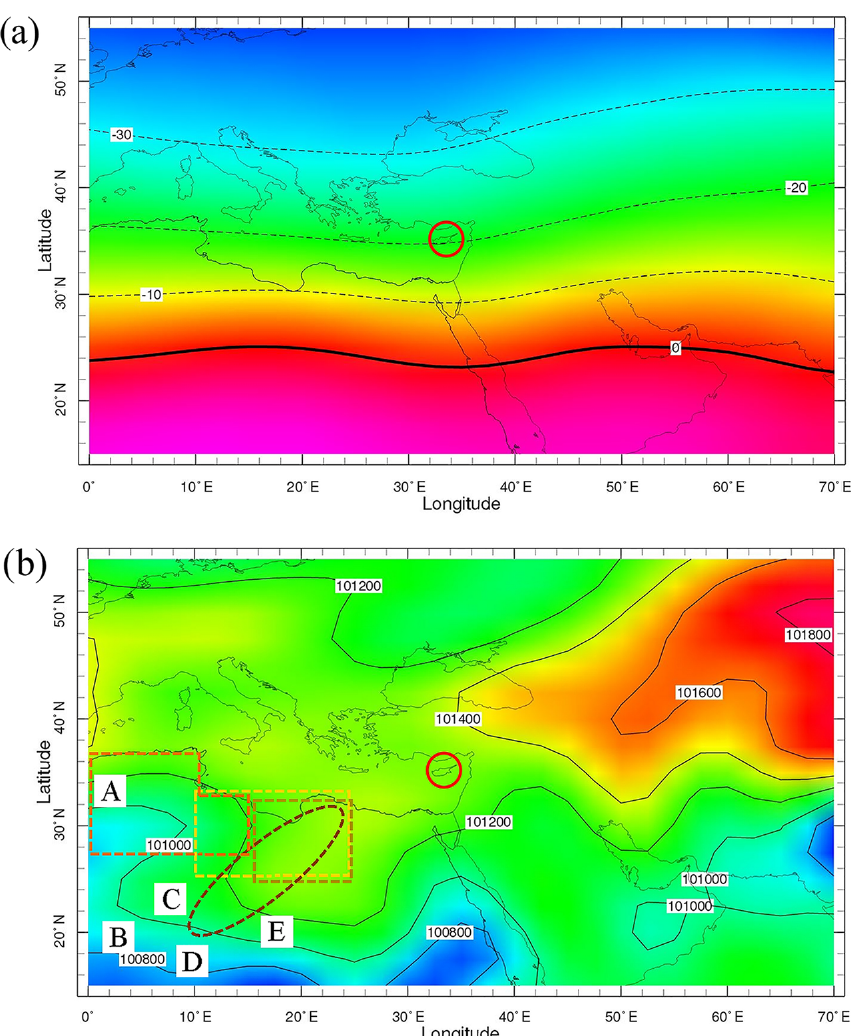
Figure 1. (a) Mean stream function at 500hPa (range: − 40 (blue) to 10 (purple)m 2 s − 1 ). (b) Mean sea level pressure (range: 100600 (blue) to 102000 (purple)Pa) in April 2016 for the Eastern Mediterranean (IRI 2016). The island of Cyprus is indicated by a red circle. Letters A to E in the lower panel refer to North African orography: A – foothills of the Atlas Mountains; B – Adrar Plateau; C – Ahaggar Mountains; D – Aïr massif; and E – Tibesti Mountains. The dashed rectangles and ellipse refer to dust source regions for this campaign (cf. Sect. 3.1 and Movie S1 in the